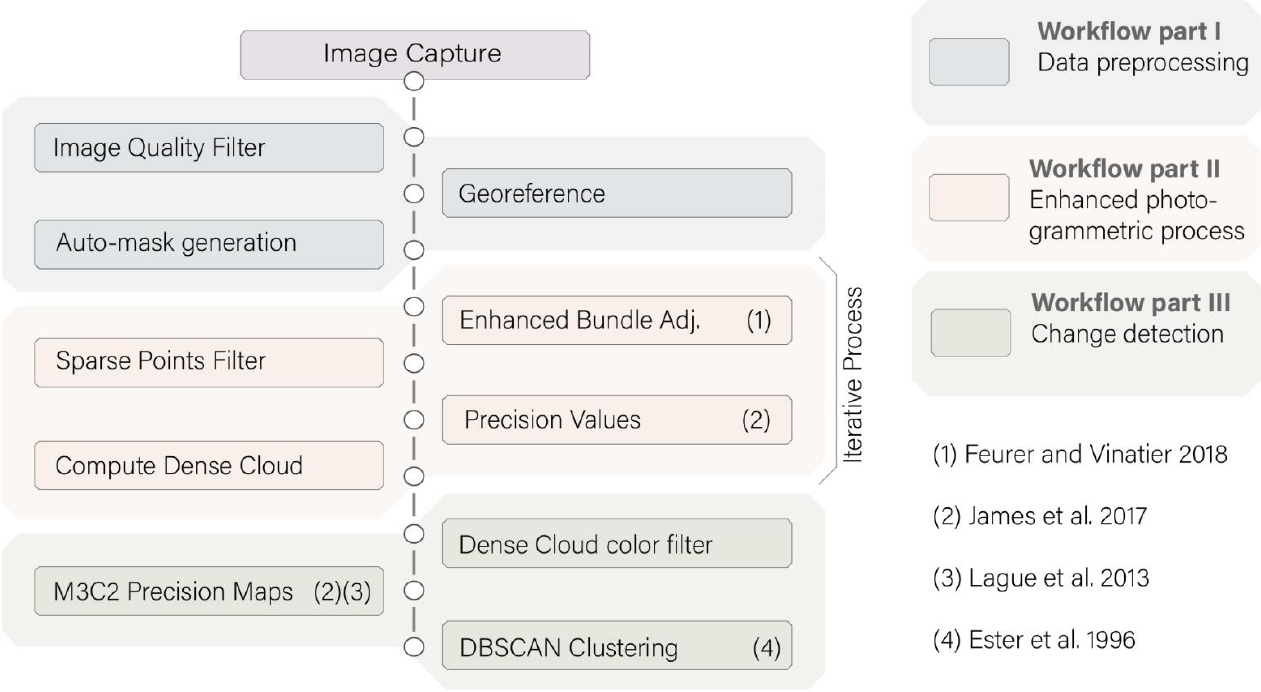
Figure 3. 4D pipeline designed for the automatic analysis of rockfalls in Puigcercós. The colours represent different parts of the process grouped according to their description in the manuscript.